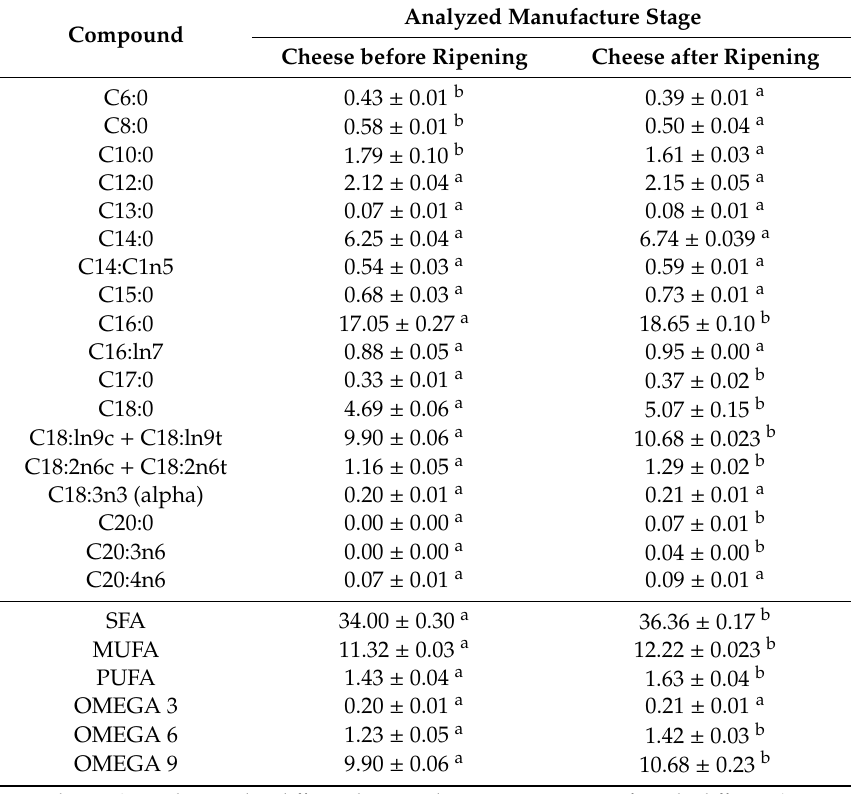
Mean values ± SD. Values with a di ff erent letter in the same row are significantly di ff erent (p <